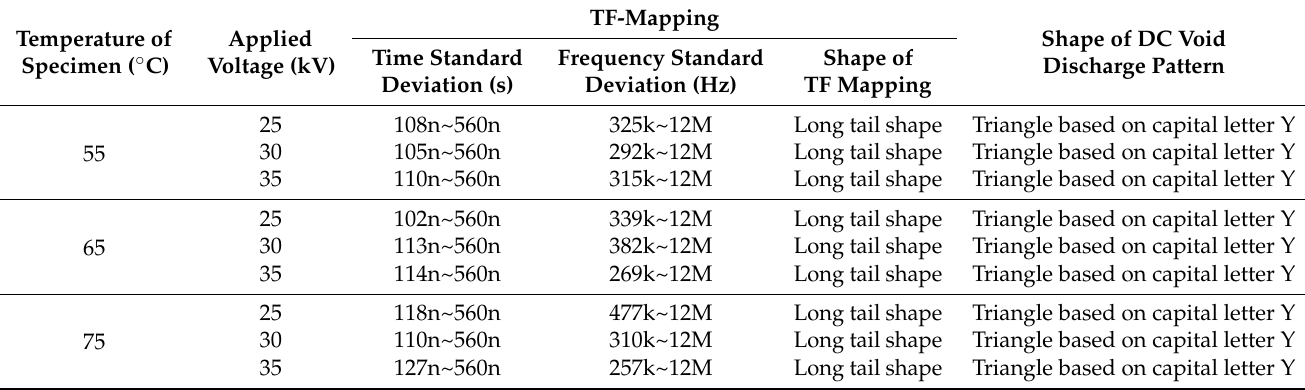
Table 3. DC void discharge characteristics and patterns according to the specimen temperature and the magnitude of applied